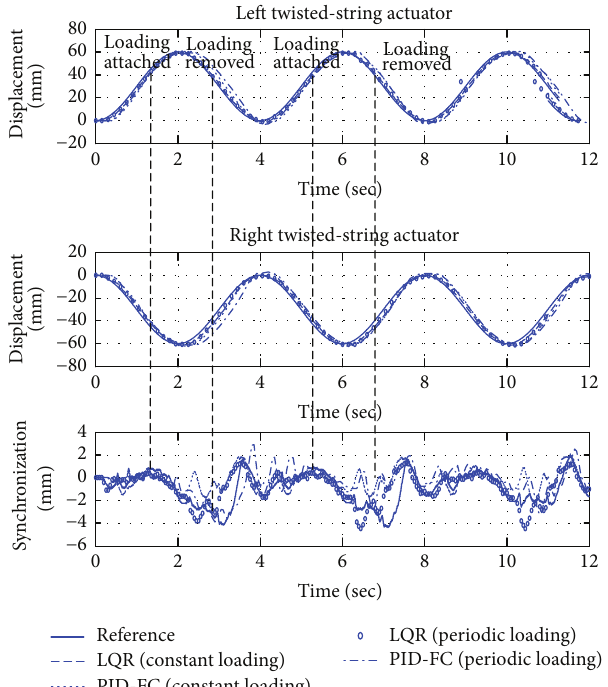
Figure 16: Tracking and synchronization performance of LQR-FC controller with 500 g fixed loading and periodic loading.